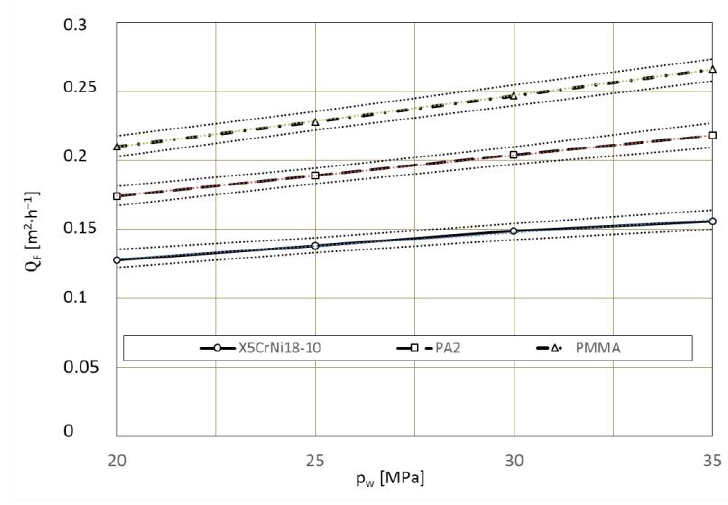
Figure 16. Influence of water-ice jet pressure p w [MPa] on the maximum surface stripping efficiency Q F [m 2 · h − 1 ] (TS = 4 × 1.2 mm, L k = 200 mm, l 2 = 250 mm,